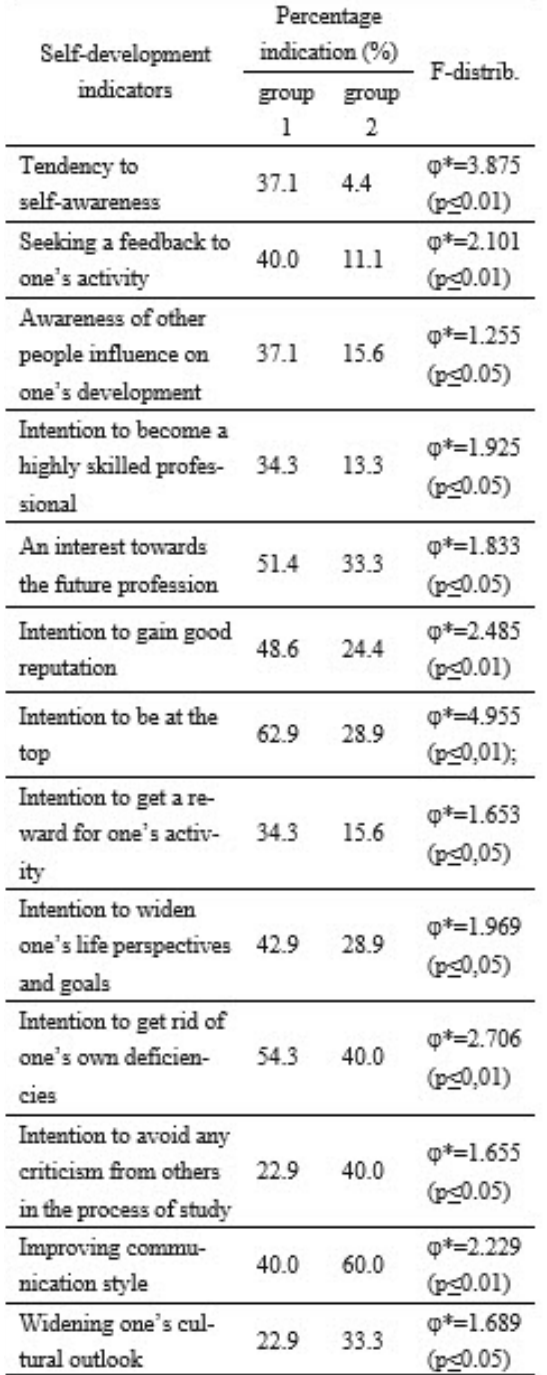
Table 1. Indicators of self-development for students with mature and diffuse life course